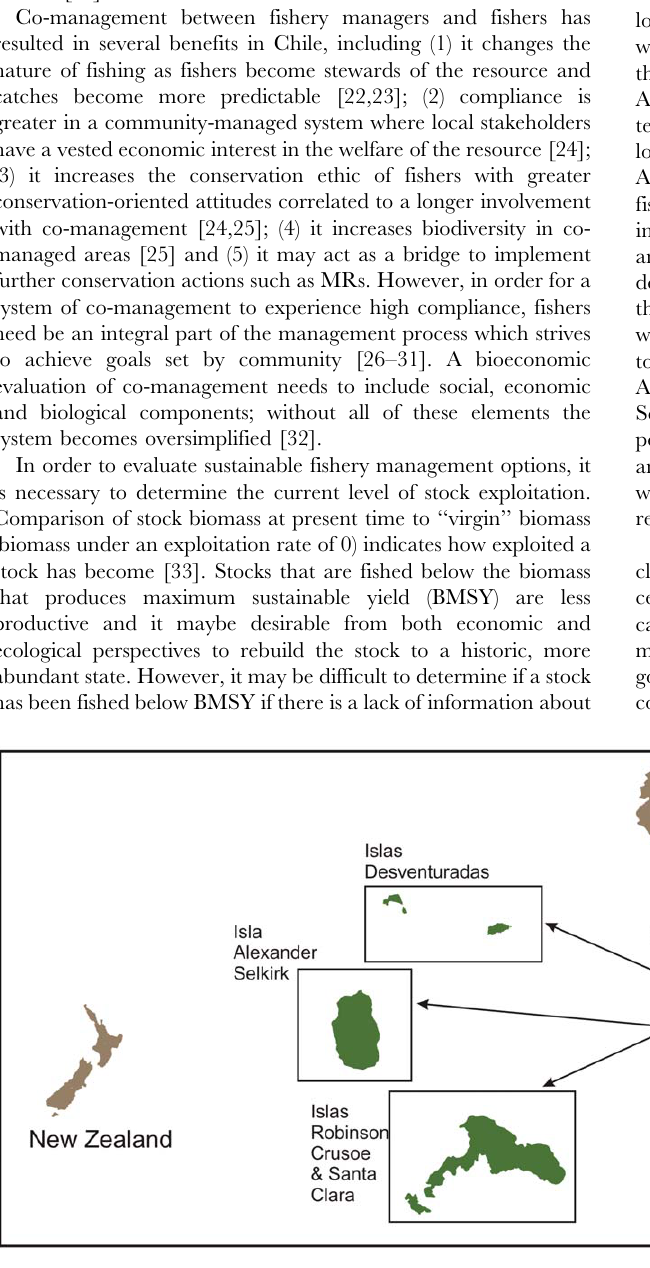
Figure 1. Location of Juan Ferna´ndez Archipelago and Islas Desventuradas in relation to Chile and New Zealand. Islas Robinson Crusoe, Santa Clara and Alexander Selkirk collectively make up the Juan Ferna´ndez Archipelago.